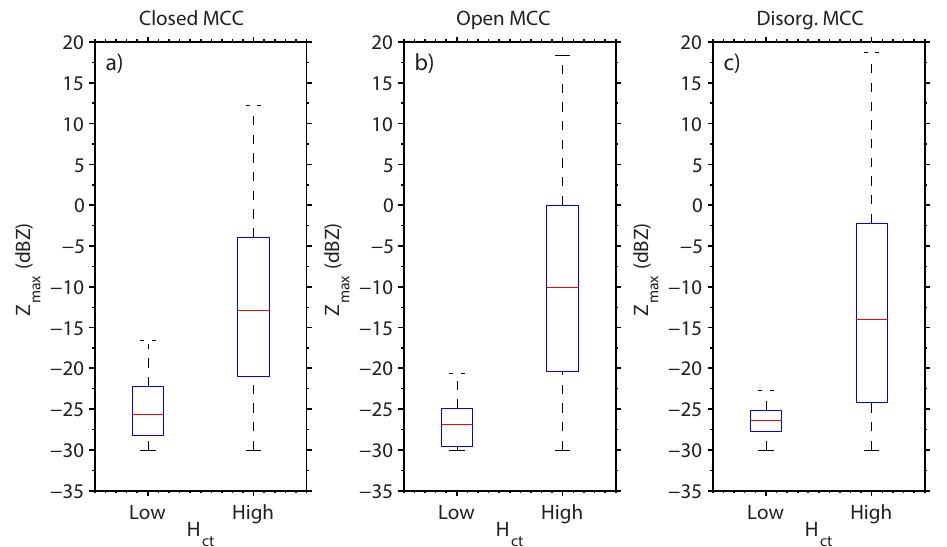
Figure 11. Box-and-whisker plots of column max. radar reflectivity Z max for each MCC category. The observations are split into two groups with low and high cloud top heights, respectively. The thresholds for dividing the data into two cloud top height groups are based on the 25th and 75th percentiles of the cloud top height distributions. The median value is shown as a red horizontal line, boxes indicate the interquartile range (25th to 75th percentile), and the whiskers extend to ± 2 σ of the standard normal